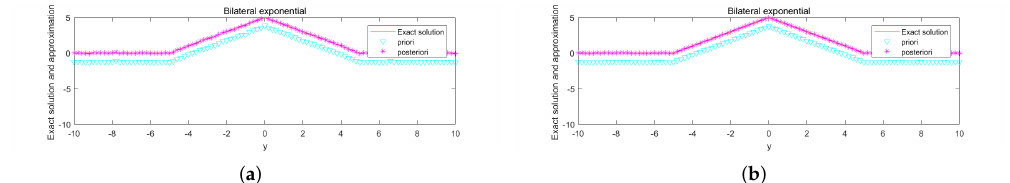
Figure 6. ( a ) δ = 1 × 10 − 1 . ( b ) δ = 1 × 10 − 2 . The exact solution and the regularized solution of b ( x ) when α = 1.4.